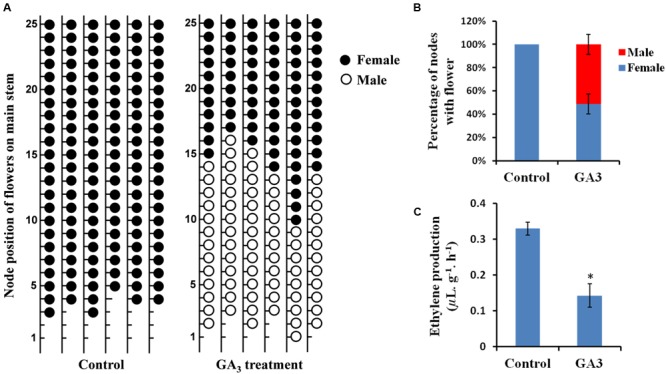
Effects of exogenous GA3 on sex expression and ethylene production in gynoecious cucumber. (A) Sex expression of the flowers on the first 25 nodes of the main stems in gynoecious cucumber plants treated with deionized water (with 0.1% ethanol) (Control) or 1000 ppm GA3. The black and white circles represent female and male flowers, respectively. Lower nodes without circle indicate the vegetative nodes. (B) The percentage of the nodes with female or male flowers up to the 25th node on the main stems of the Control and GA3 treatment lines. Values are the means ± SE from six independent plants. (C) Quantification of ethylene released from shoot tips in gynoecious cucumber plants at 7 days after treatment with GA3 and the Control. Six biological replicates were performed for this experiment. Vertical bars represent the standard errors. The asterisk indicates the significant difference (P < 0.01) between the Control and GA3 treatment lines by Duncan’s test.